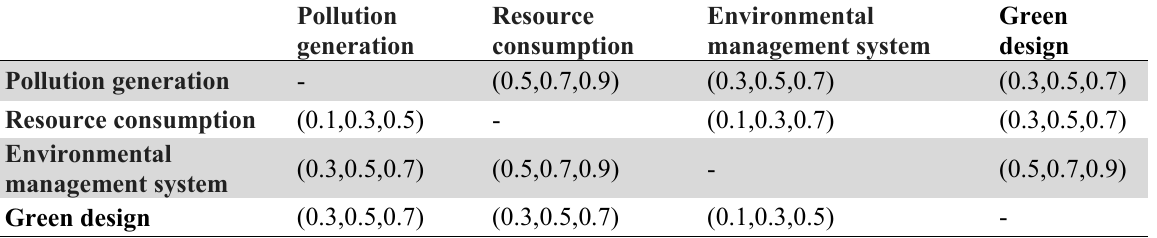
Paired-wise comparison of environmental sub-criteria